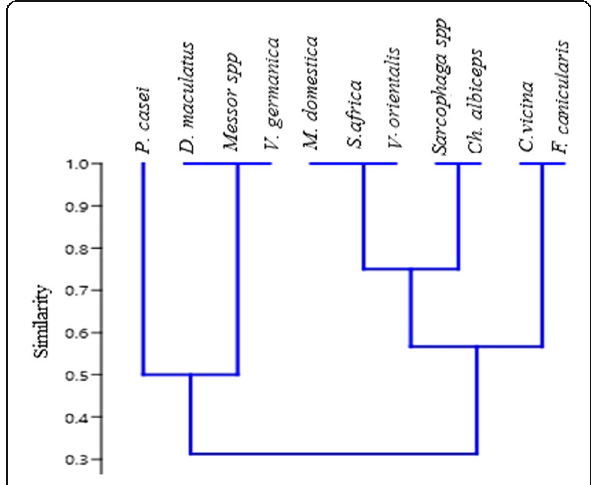
Fig. 3 Cluster analysis based on Jaccard ’ s distance in the outdoor habitat; cophenetic correlation =